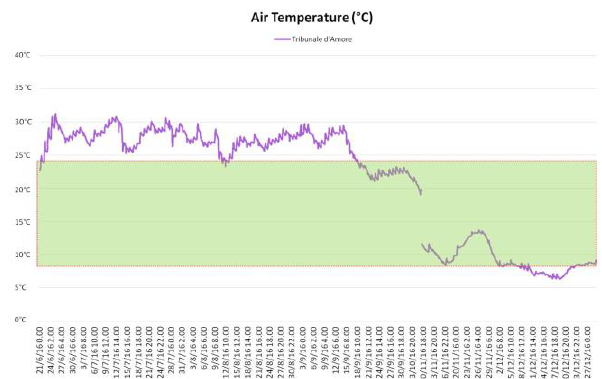
Figure 5. Air Temperature Trend and HMR (T) Range, Room (3) Tribunale D’Amore